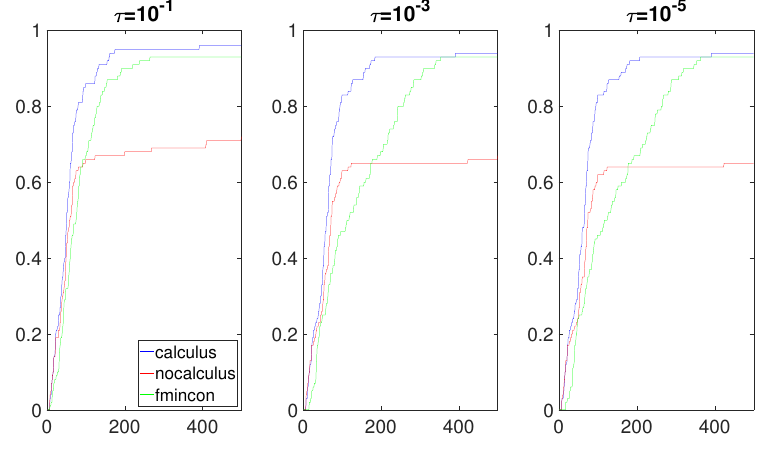
Figure 9. Data profiles when F = f 1